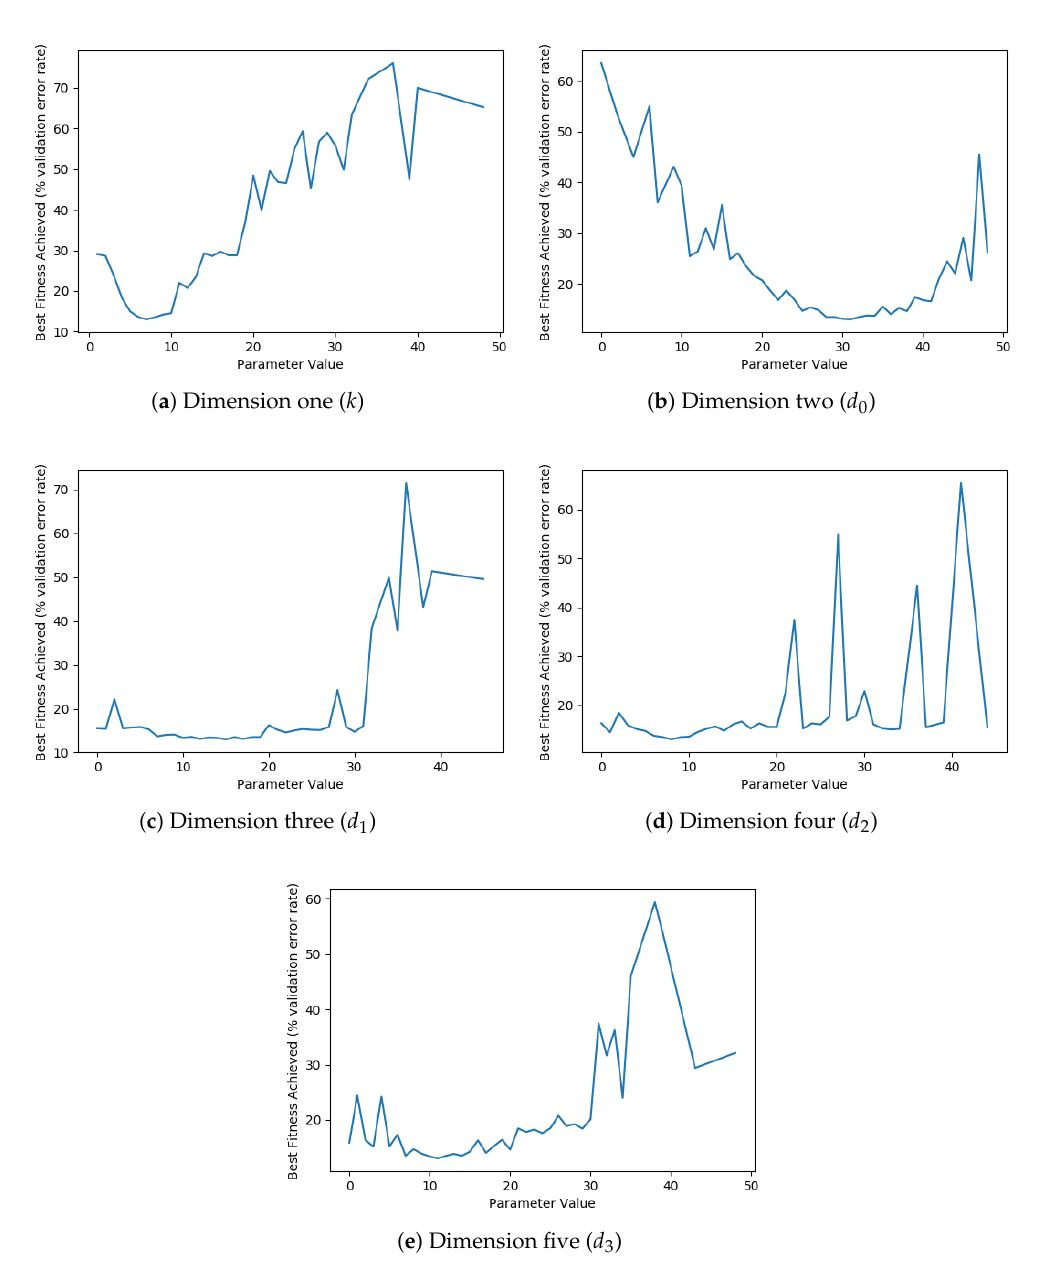
Figure 9. Visualisation of the best fitness scores achieved for different parameter values in each dimension using the BLSK-NS weight inheritance